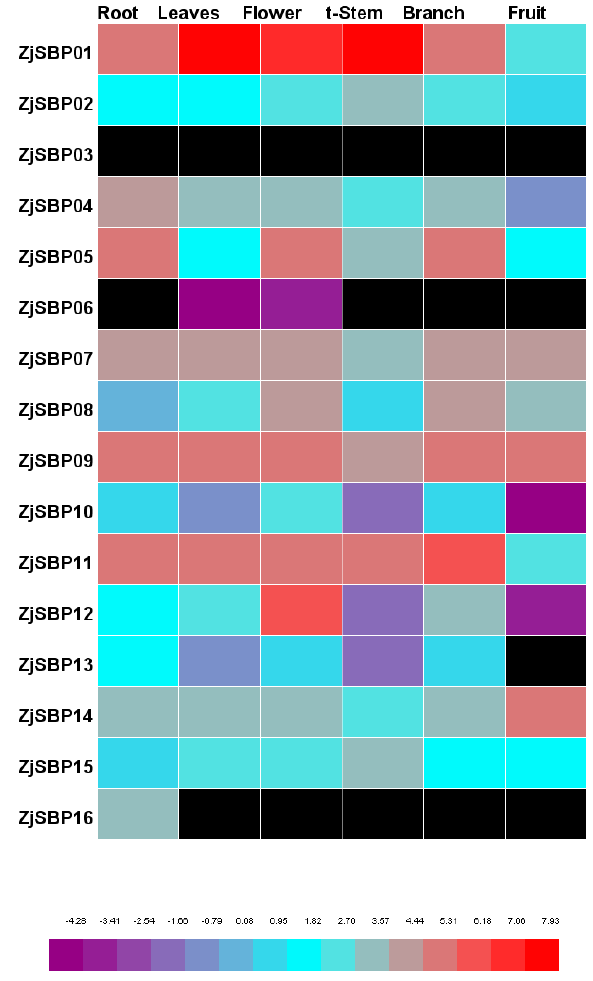
Figure 8. Expression quantities of ZjSBPs for different transcriptomes in different tissues by Heml 1.0.